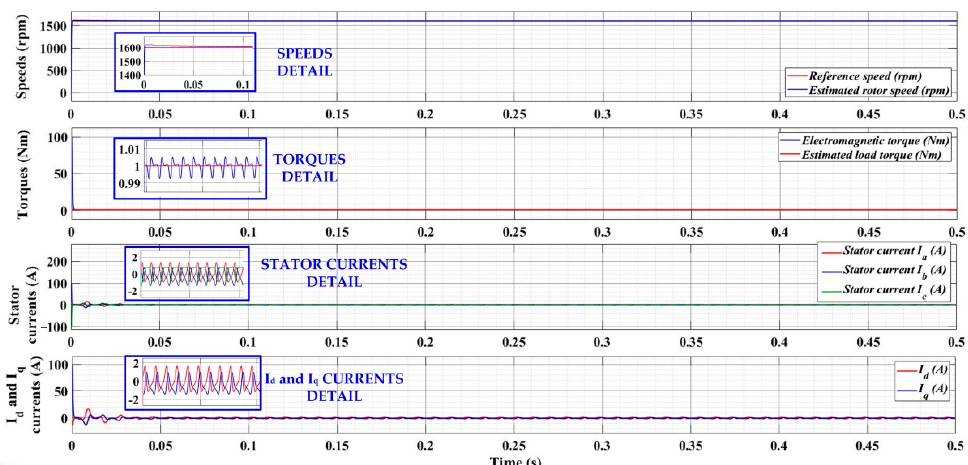
Figure 19. Time evolution for the numerical simulation of the PMSM control system based on the backstepping-PSO controller: ω ref = 1600 rpm, T L = 1 Nm, K ω = 0.01, K I ω = 140, K q = 5000, K Iq = 50, γ = 0.01, K d = 300, and K id = 300.